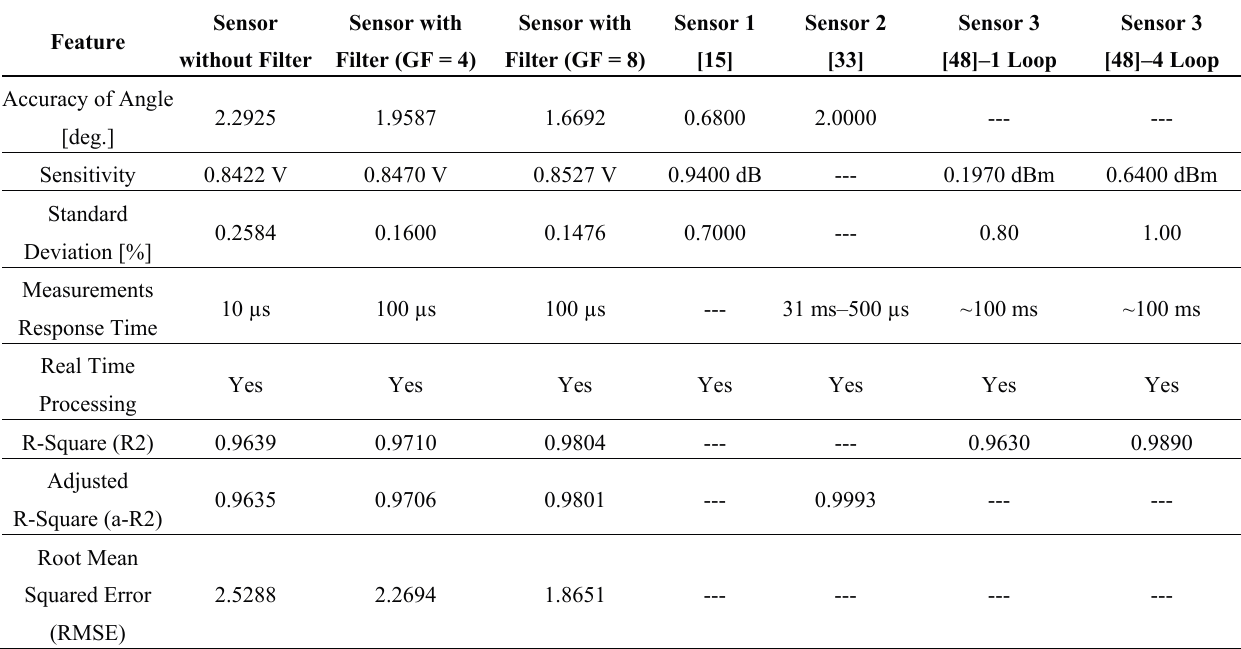
Table 2. Analysis comparative of seven sensor features and the lineal model for the proposed sensor and three more sensors proposed in the literature ( --- means that the corresponding data is not provided by the